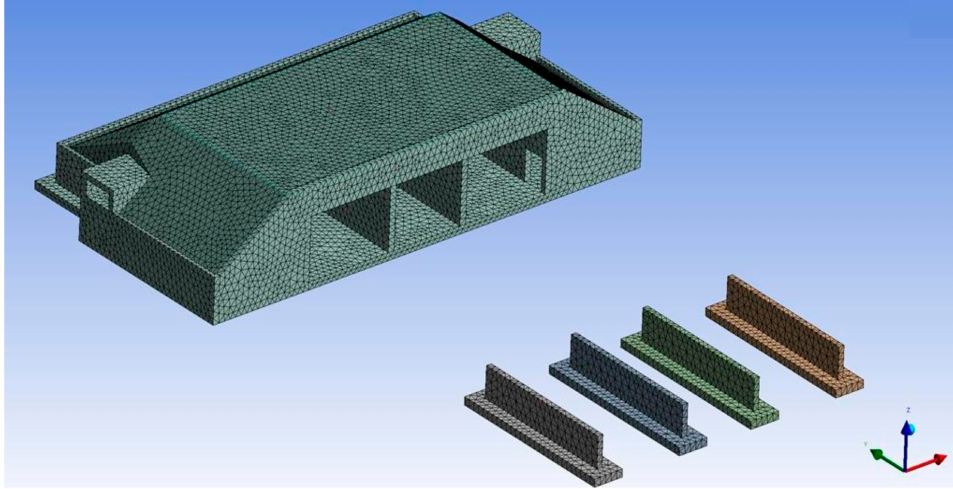
Figure 6. Finite element model developed.